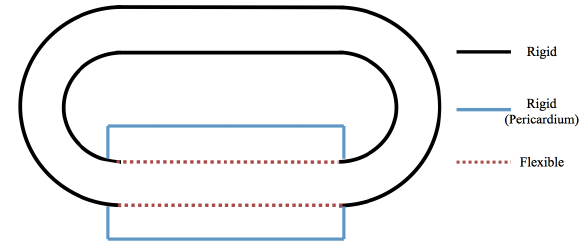
Fig. 5: Computational geometry for the electro- mechanical pumping model. The racetrack is held stiff (black), except for the bottom straight-tube portion, which is flexible (red). There is a stiff pericardium model surrounding the flexible region (blue).